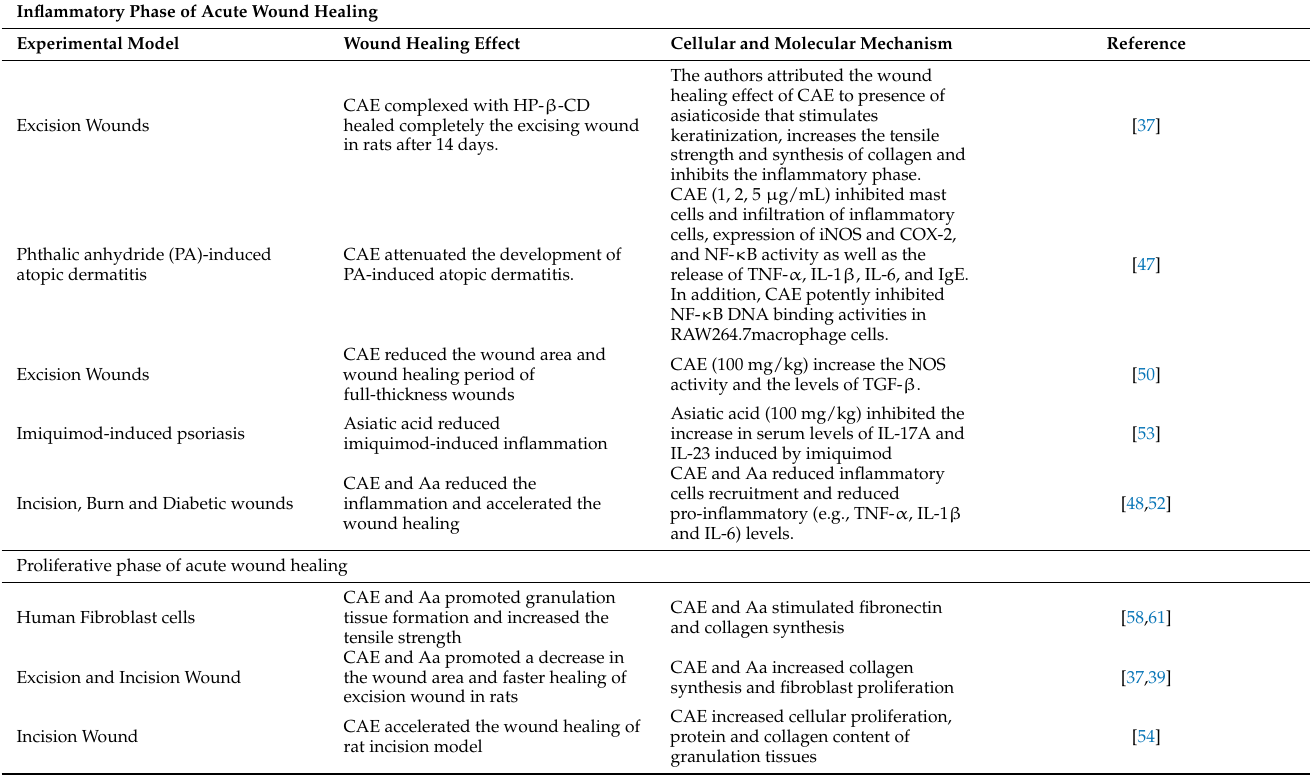
Table 1. Wound healing effects of Centella asiatica and asiatic acid in different phases of skin repair